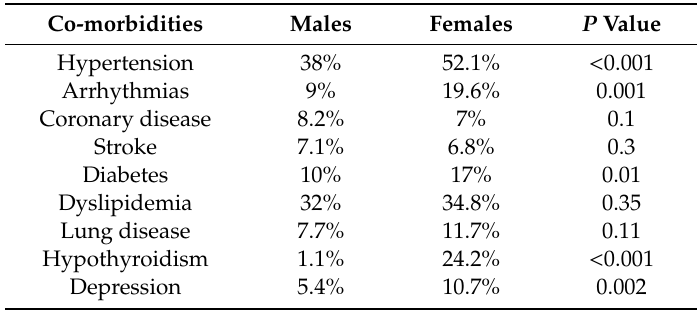
Table 2. Di ff erences between genders concerning